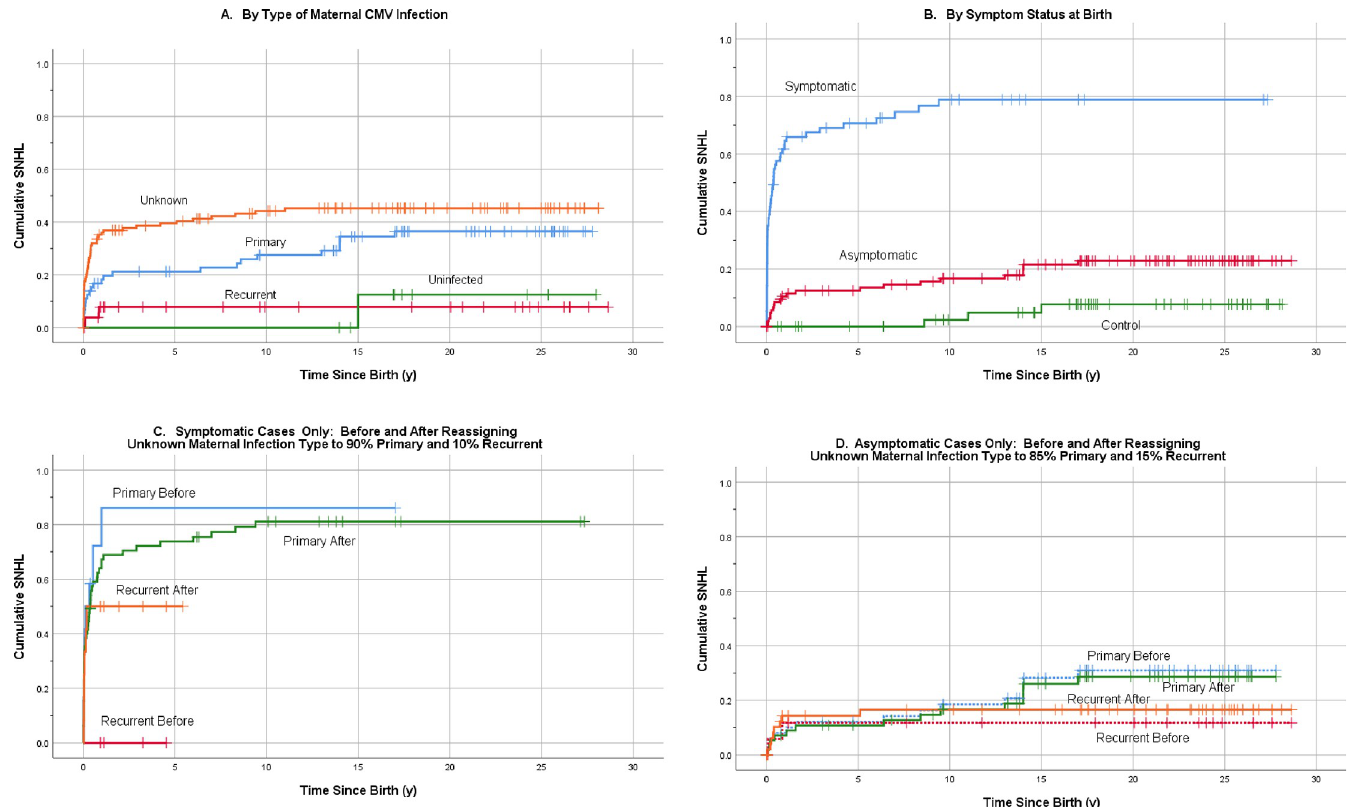
Fig 2. Kaplan-Meier hearing loss survival curves for maternal infection categories. (A) Survival curves by maternal serology type. Comparison of Survival Curves by Log-Rank test: Unknown vs. primary (p = .068); Unknown vs. non-Primary (p = .001); Unknown vs. uninfected (p = .042); Primary vs. non-Primary (p = .026). (B) Survival curves by symptom group at birth. Comparison of Survival Curves by Log-Rank test: Symptomatic vs. Asymptomatic (p < .001); Symptomatic vs. Control (p < .001); Asymptomatic vs. Control (p = .019). (C) Survival curves of symptomatic cases before and after reassigning those with unknown type of maternal CMV infection into Primary and Recurrent infection categories. Comparison of Survival Curves by Log-Rank test: Primary Before vs. Primary After (p = .576); Non-Primary Before vs. non-Primary After (p = .107); Primary Before vs. non-Primary Before (p = .016); Primary After vs. non-Primary After (p = .313). (D) Survival curves for asymptomatic cases before and after reassigning those with unknown type of maternal CMV infection into Primary and Recurrent (non-Primary) infection categories. Primary Before vs. Primary After (p = .797), Non-Primary Before vs. non-Primary After (p = .651), Primary Before vs. non-Primary Before (p = .218), Primary After vs. non-Primary After (p = .333).